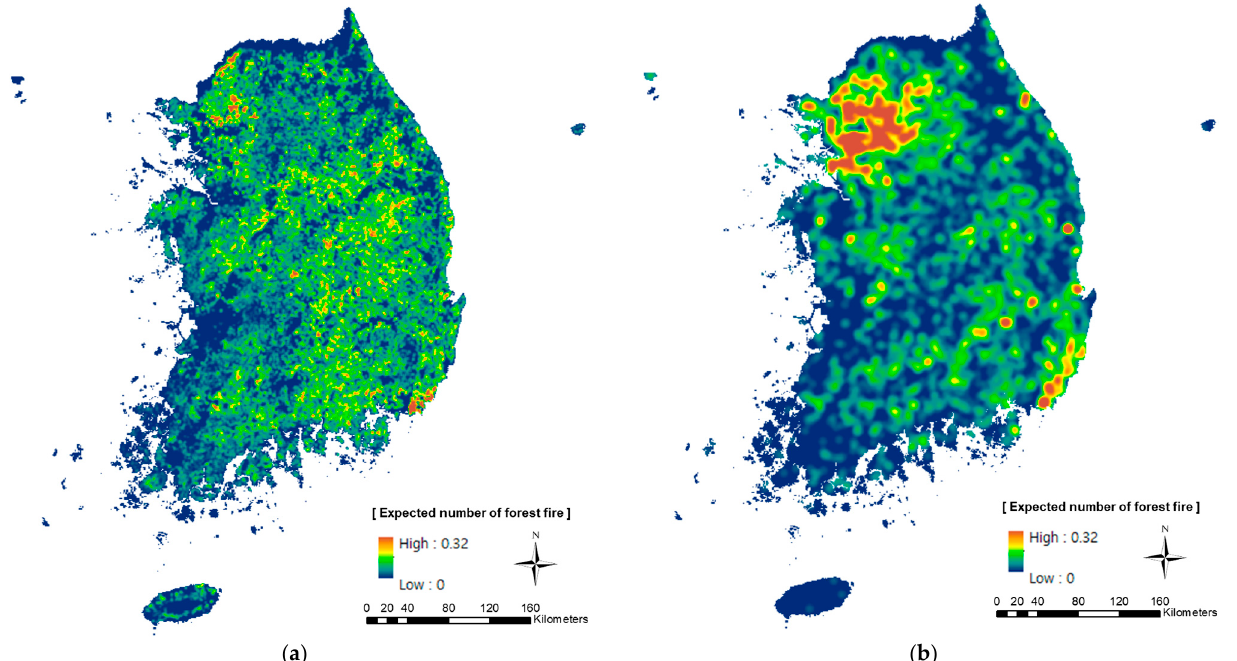
Figure 14. Expected number of forest fires throughout the study period: ( a ) simulation of the optimized FLAM, ( b ) observation.